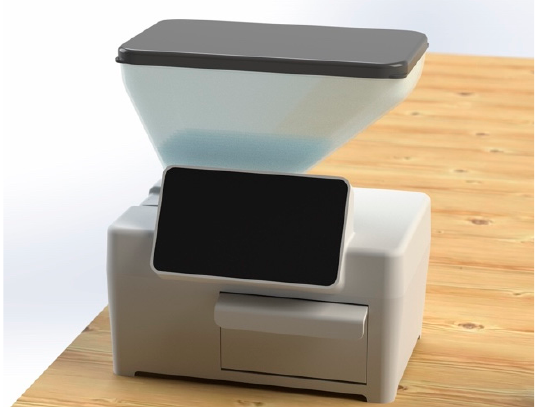
Figure 2. Salt Control-C equipment.